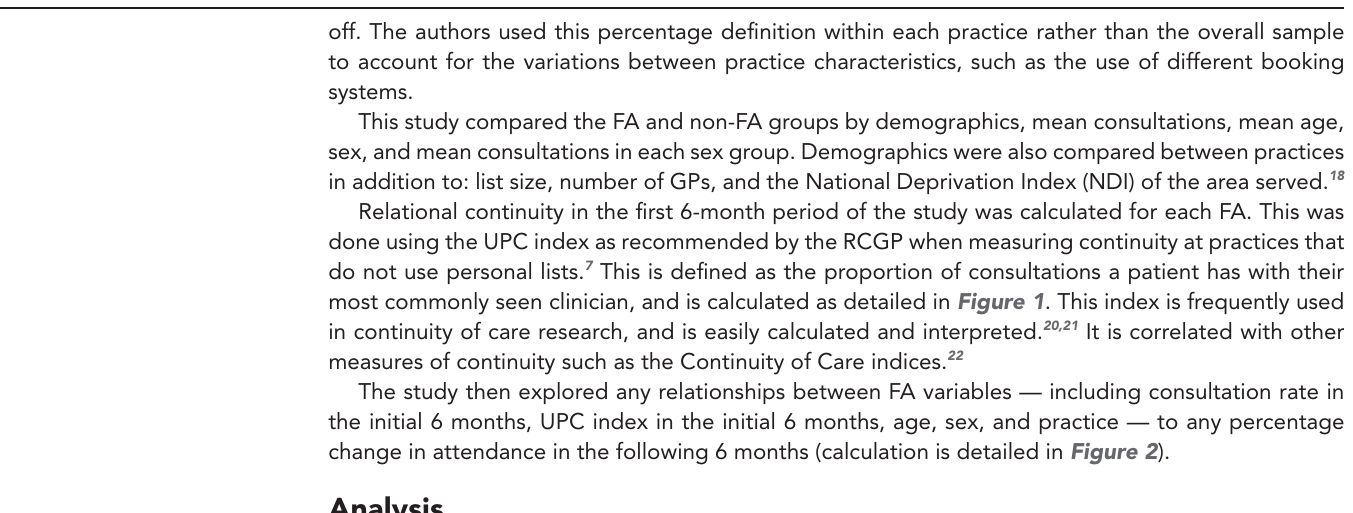
Figure 1 Calculation of Usual Provider Continuity index